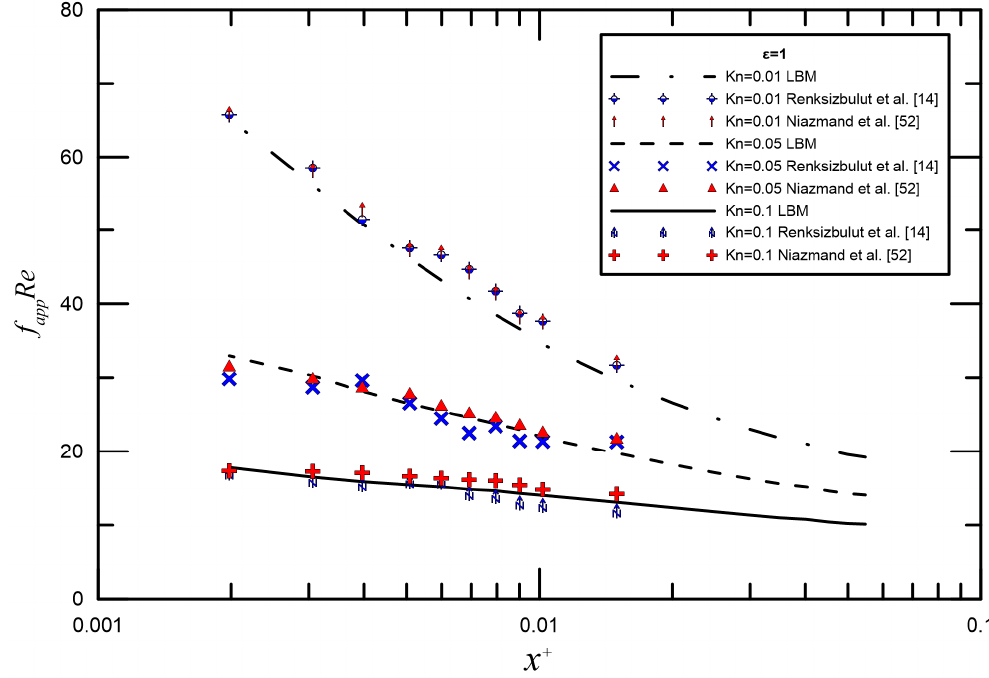
Figure 5. Comparison of f app Re for the numerical data by Renksizbulut et al. [14] and Niazmand et al. [52] for ε = 1 in the slip flow regime.